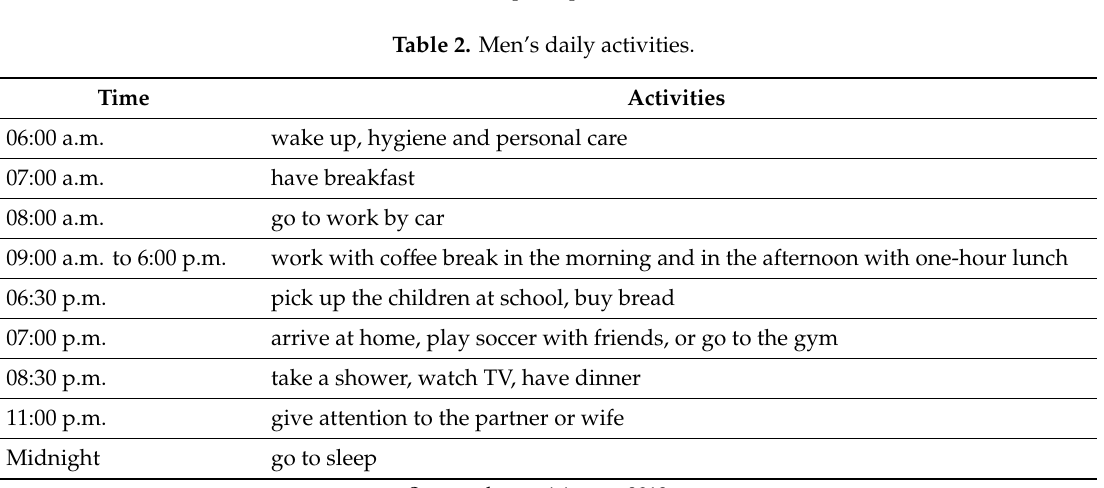
Table 2. Men’s daily